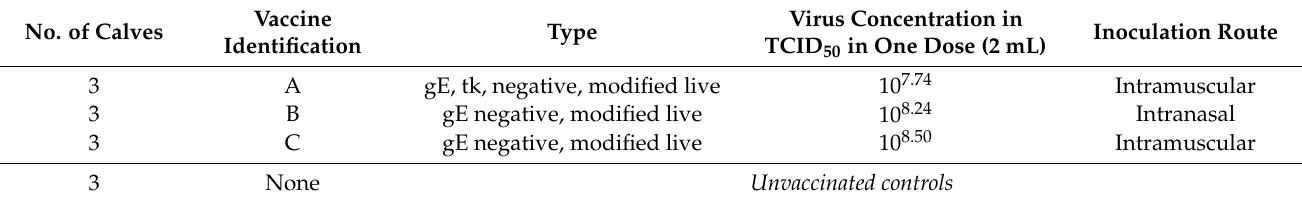
Table 1. Bovine alphaherpesvirus-1 (BoHV-1) vaccines used in the experiment. No. of